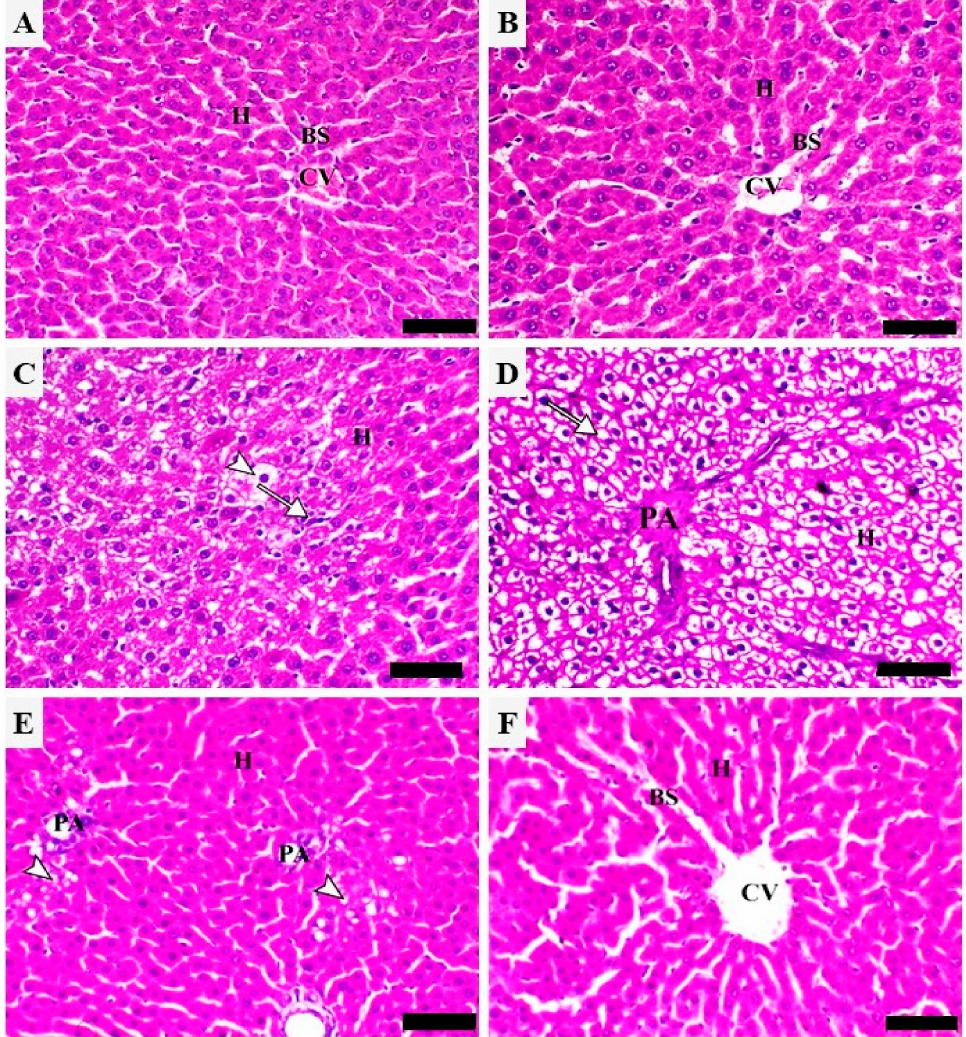
Figure 3. API prevented CP-induced tissue injury. Photomicrographs of sections in the liver of ( A ) control and ( B ) API-administered rats showing a normal histological architecture with normal hepatocytes (H) radially arranged in cords around central veins (CVs) and normal sinusoids (BS); ( C , D ) CP-intoxicated rats showing marked granular hepatic vacuolation (arrowheads), mononuclear cells infiltration (arrow) [C], and advanced hydropic changes (arrow) [D], PA indicates portal area and H indicates hepatocytes; ( E , F ) CP-intoxicated rats treated with 20 mg/kg API ( E ) showing focally limited periportal hepatic vacuolation (arrowheads), and 40 mg/kg API ( F ) showing a marked decrease in hepatic vacuolation with mild congestion of the blood sinusoids (H&E, Scale bar = 50 µ